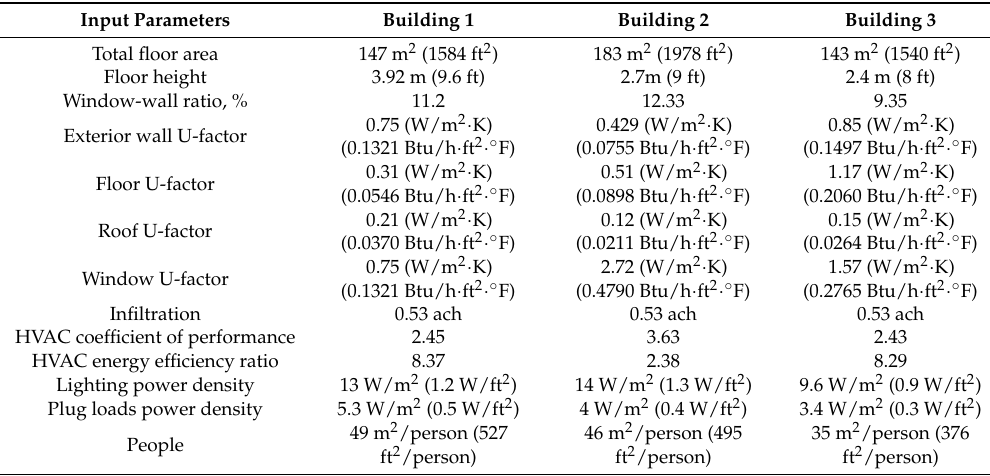
Figure 1. Selected sample buildings: ( a ) two-story wood frame (Building 1), ( b ) one-story concrete block (Building 2), and ( c ) one-story wood frame (Building 3). Table 1. Simulation model inputs.